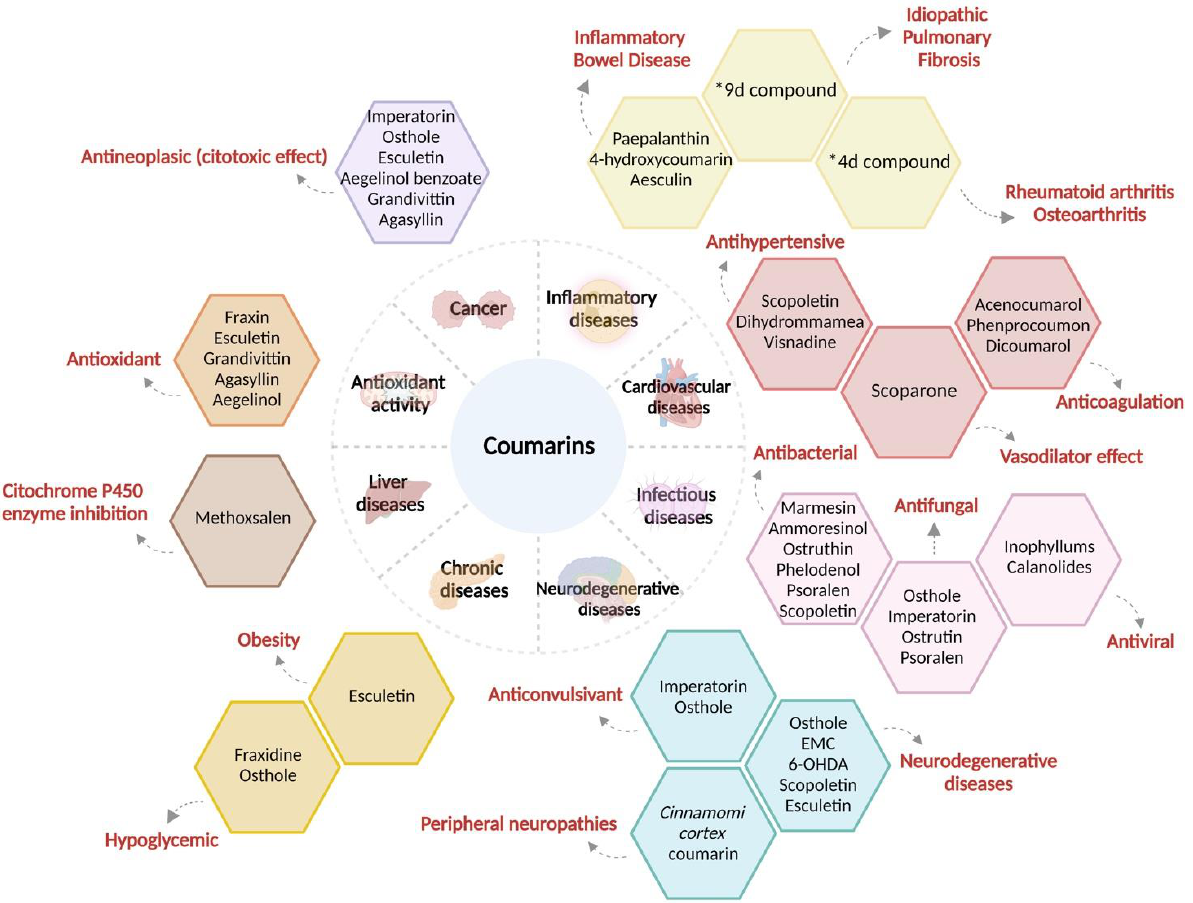
Figure 2. Properties and pharmacological effects of coumarins and coumarin derivatives against human diseases. A wide range of effects and pharmacological properties of cumarins have been reported; as we can see, scopoletin, esculetin, and osthole have been the most described coumarins to be involved in the modulation of different systems such as cardiovascular and neurological system. A great knowledge of coumarins is their variety number of antineoplastic properties, acting as cytotoxic compounds in different kinds of cancer. *9d compound: ( N -(4-((2-((2-oxo-2 H -chromen-4- yl)oxy)phenyl)-2-(piperidin-1-yl)acetamide); *4d compound: 3-(1 H -benzo[ d ]imidazol-2-yl)-6- chloro-2 H -chromen-2-one.